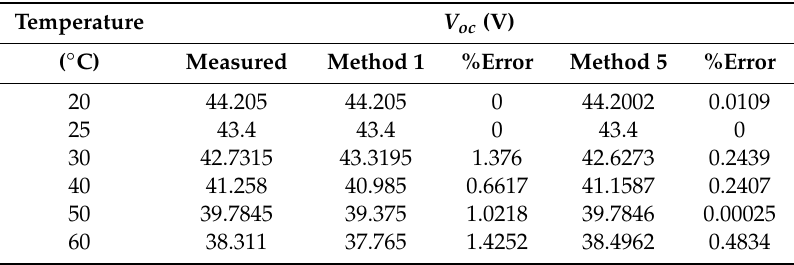
Table 9. The calculated (Methods 1 and 5) and measured V oc (V) and relative error of the shell SQ150 module under di ff erent temperatures and an irradiance of 1000 W / m 2 .